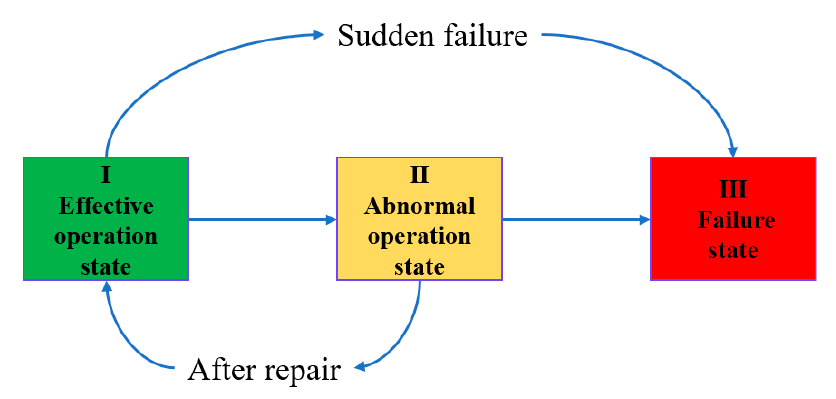
Figure 2. Three-state progressive model.